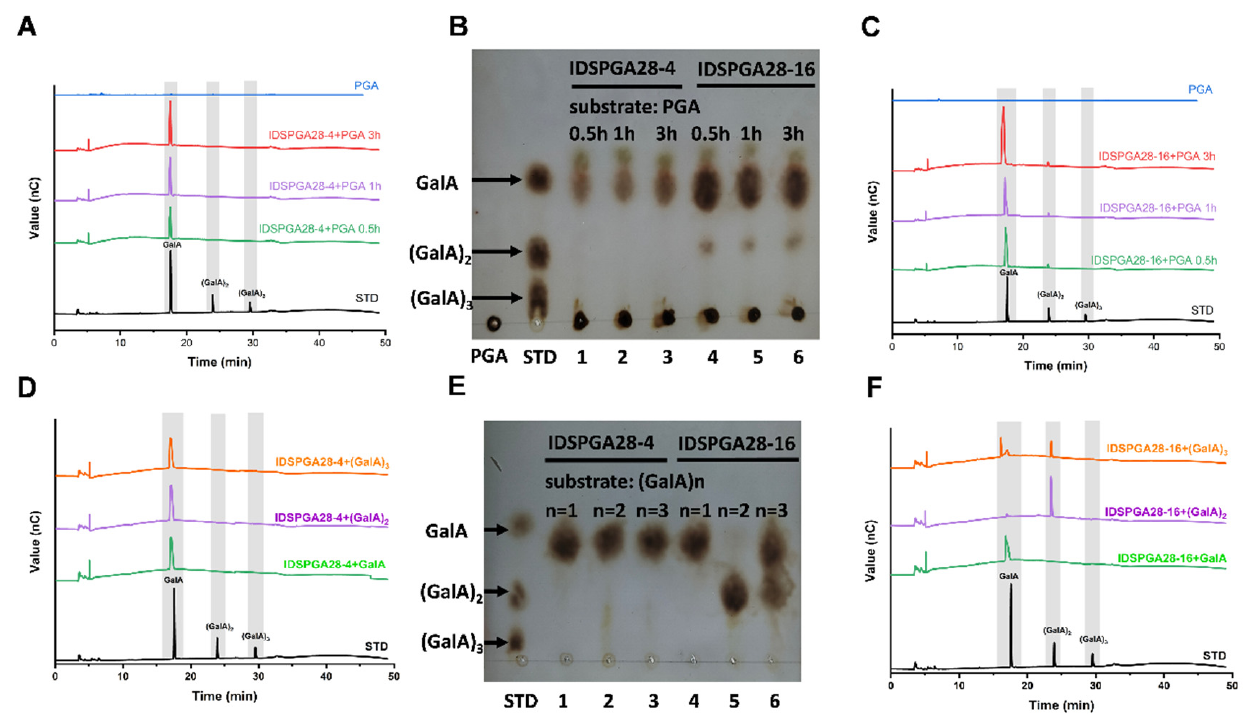
Figure 4. Substrates hydrolysis by IDSPGA28-4 and IDSPGA28-16, analyzed by TLC and HPAEC.